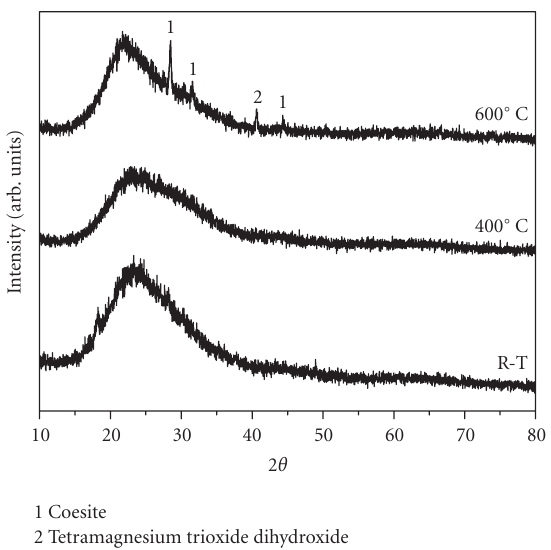
Figure 2: X-ray di ff raction patterns of the chlorophyll-containing silica xerogel samples heat-treated at the indicated temperatures.